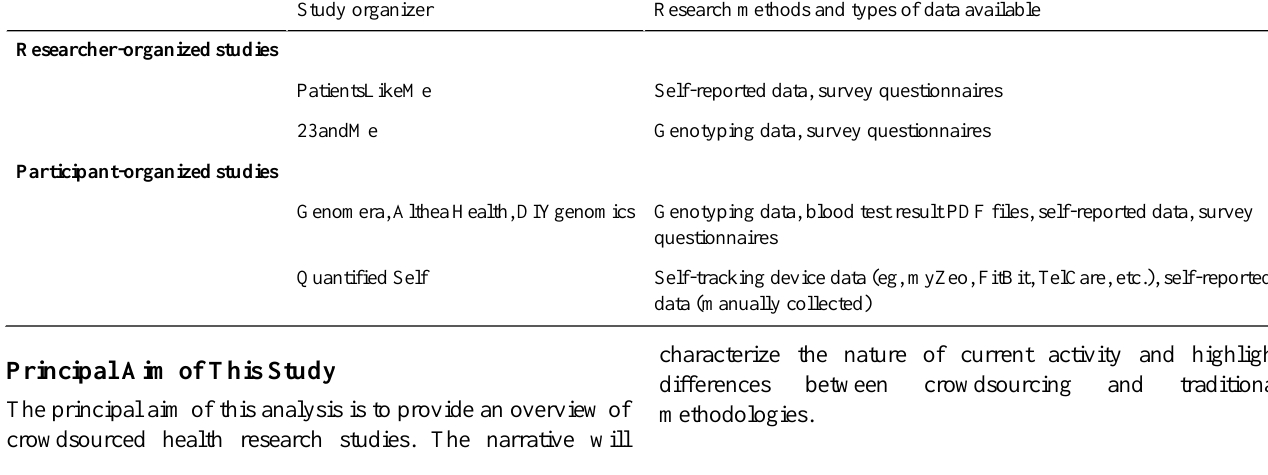
Research methods and types of data availableStudy